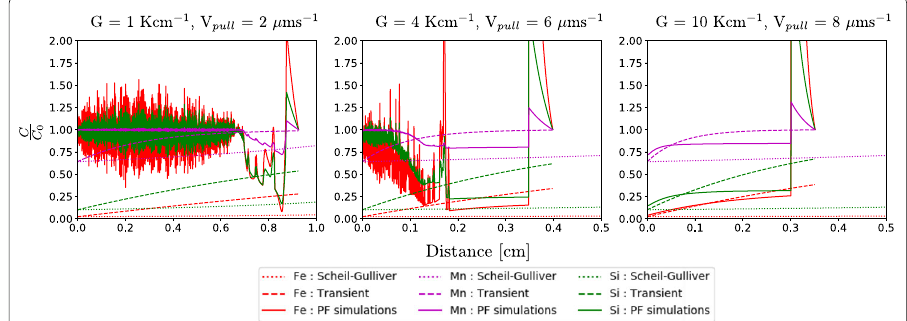
Fig. 7 Impurity concentrations in solid as function of z, z = 0 corresponds to the bottom of the simulation domain. Solid lines: results from phase field simulation. Dotted-dashed: Scheil-Gulliver model (Eq. 8). Dashed lines: initial transient according to Eq. 7. Impurity elements Fe in red, Si in green and Mn in magenta, respectively